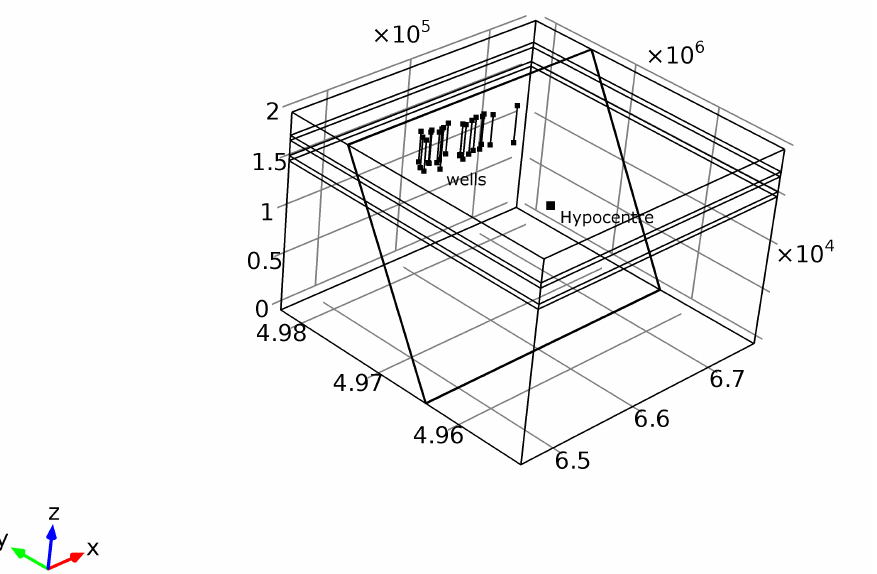
Figure 13. View of the domain with wells and the May 29th earthquake hypocentre.